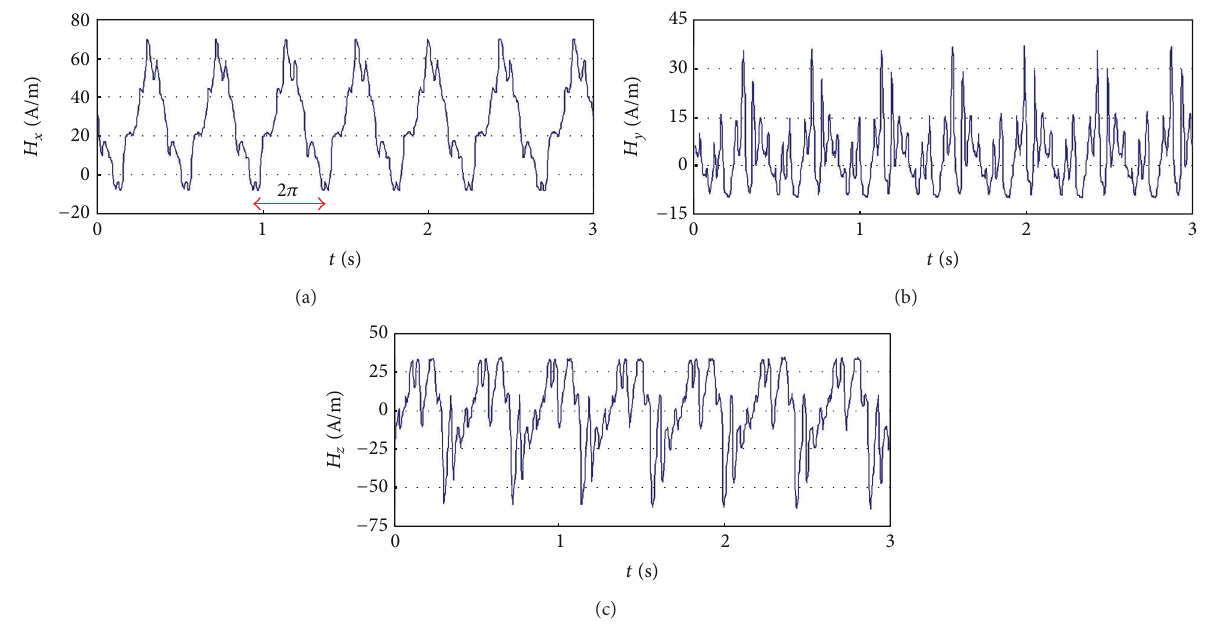
Figure 25: Components of the magnetic field measured on the suface of compressor casing ( 𝐻 𝑥 : along the pivot of the engine, 𝐻 𝑦 : tangensial to the casing, and 𝐻 𝑧 : normal to the surface)